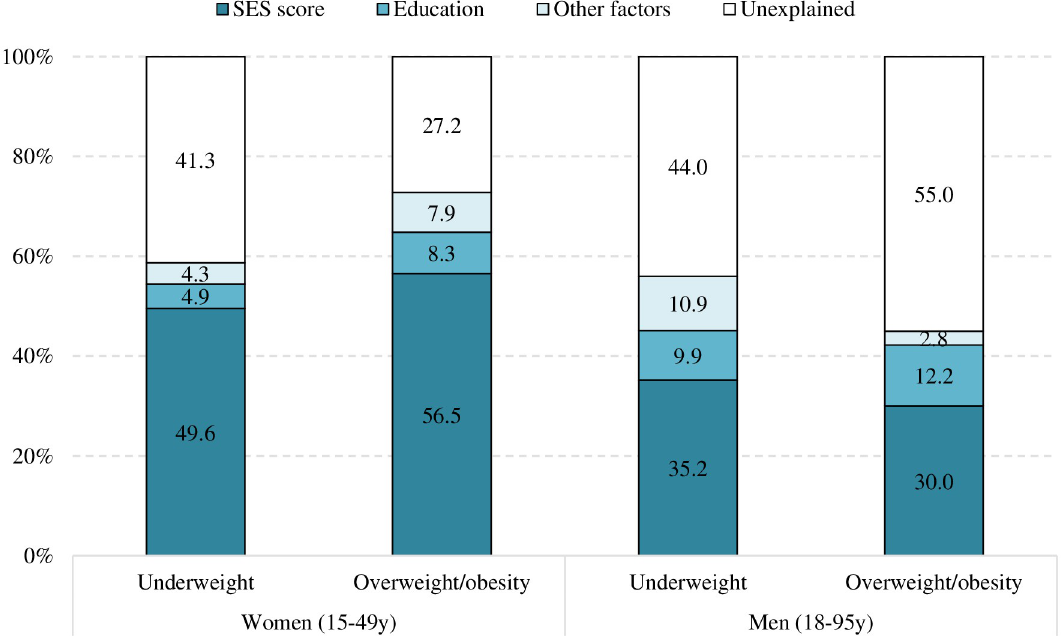
Fig 6. Regression decomposition analysis of factors that explain changes in underweight and overweight/obesity in women (2004–2018) and men (2011–2018). Other factors include hygiene and sanitation in men, and household size, hygiene and sanitation, age, working status, and having children under 5 year in